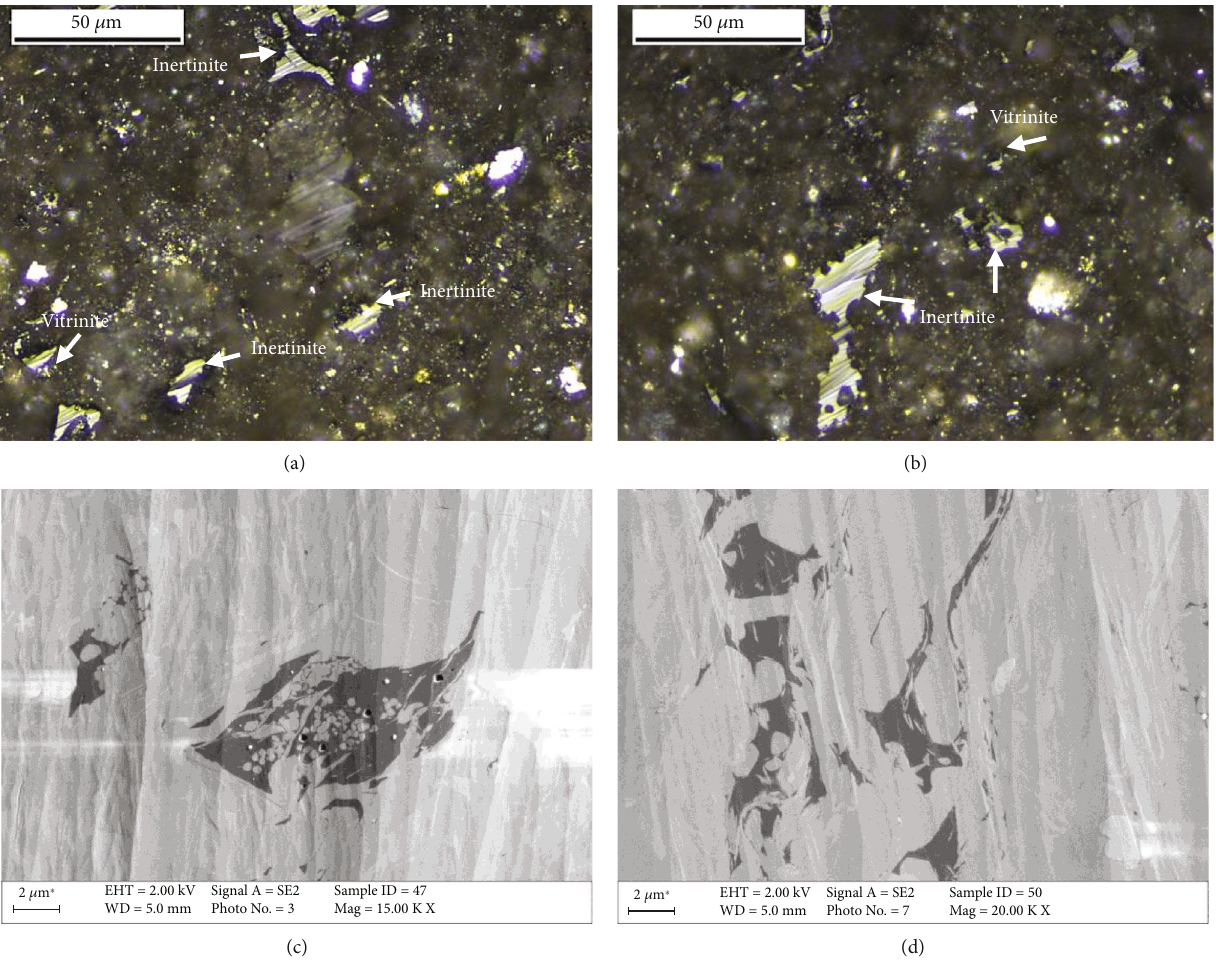
Figure 8: (a, b) Organic petrography photomicrographs (oil immersion, white incident light) of Ordos shale. The maceral of Ordos shale is composed of vitrinite and inertinite. (c, d) SEM images showing typical maceral types and the internal pore structure of Xiuwu